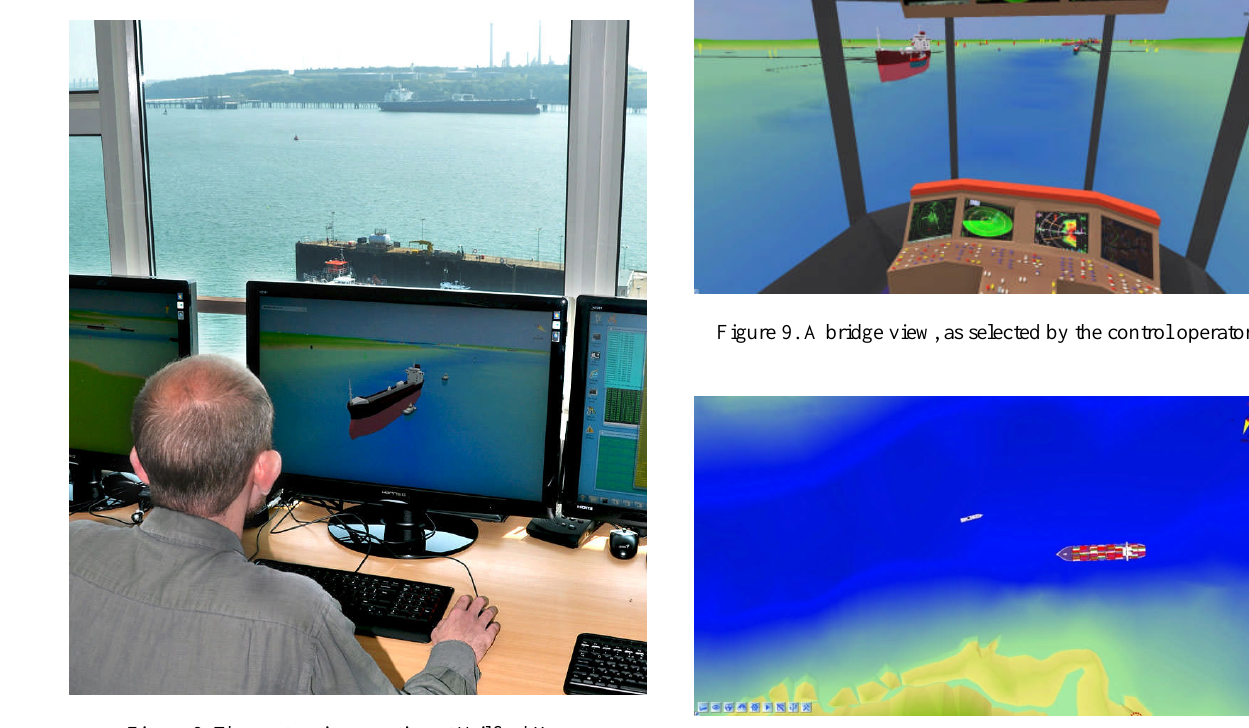
Figure 6. The system in operation at Milford Haven